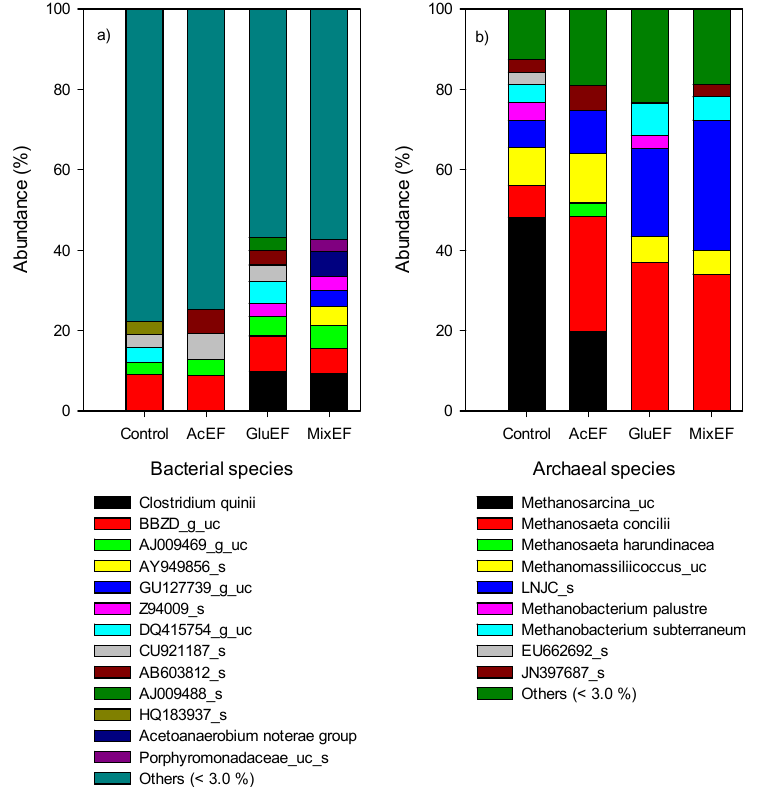
Figure 4. Microbial communities depending on the substrate type in the anaerobic reactor exposed to the electric field: ( a ) bacterial species, and ( b ) archaeal species.